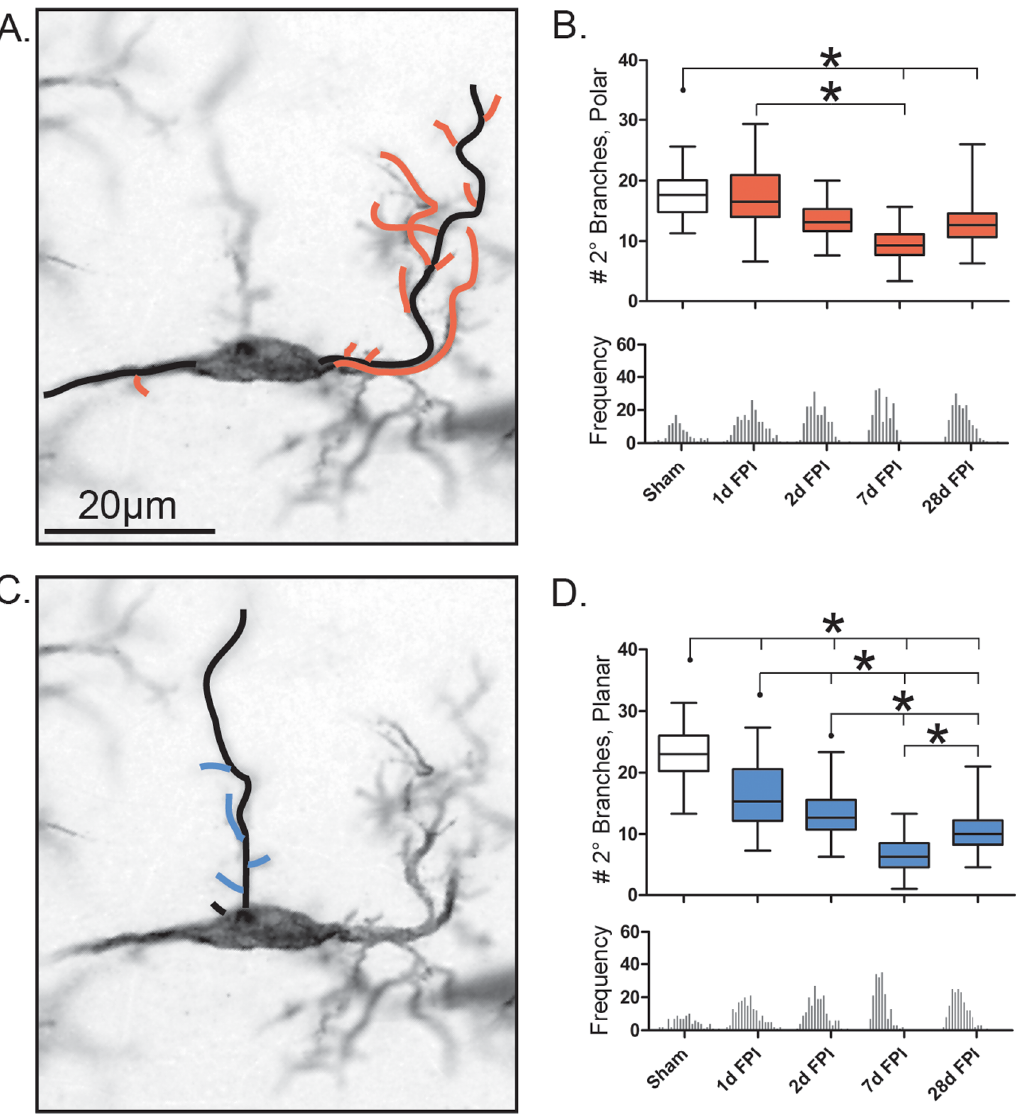
Figure 5. Decrease in the number of rod microglial secondary branches post-injury. (A, C) Representative 28 day post-FPI Iba1-positive rod microglia, 100x. The black lines illustrate the already measure primary branches. The orange and blue lines illustrate the secondary polar and planar branches respectively, secondary branches defined as those directly protruding off of a primary branch. (B) Number of secondary polar branches present on the cell. (D) Number of secondary planar branches present on the cell. Populations described by a box and whisker plot. Notches of each frequency histogram represent the bin center for that specific time point. In both cases a Gaussian distribution is observed. Significance was calculated using the average mean values for each time point (n=3/time point; *, P , 0.05, one-way